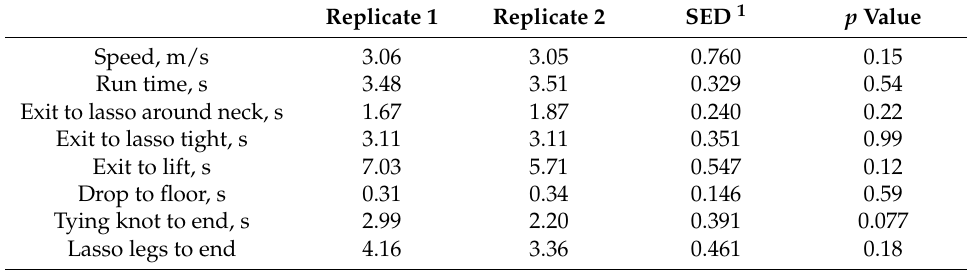
Walk speed, m/s Table 4. Least square means for behaviours in replicates 1 and 2 for Experienced Roped (ER)